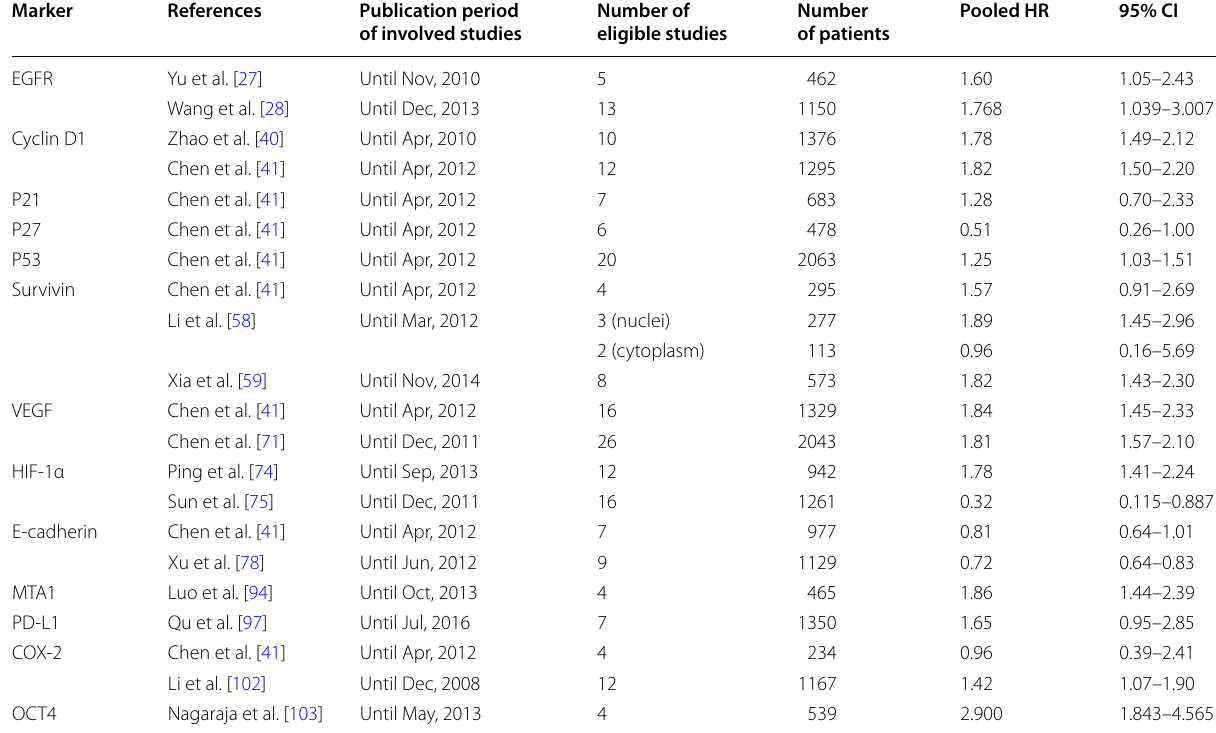
Table 1 Meta-analyses references of the studies on candidate IHC markers for survival in